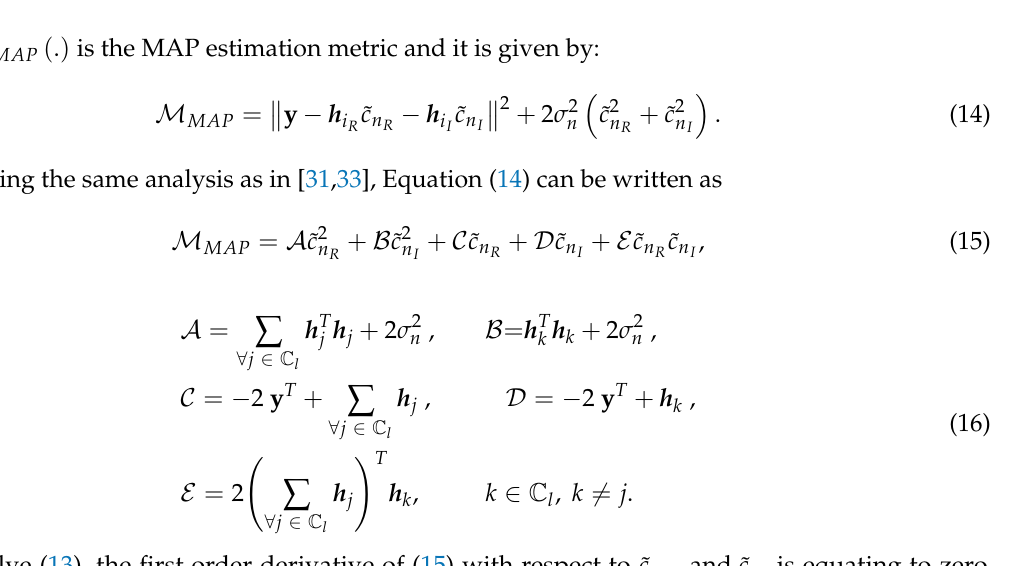
, and ˜ c n for each expected joint power allocations R I